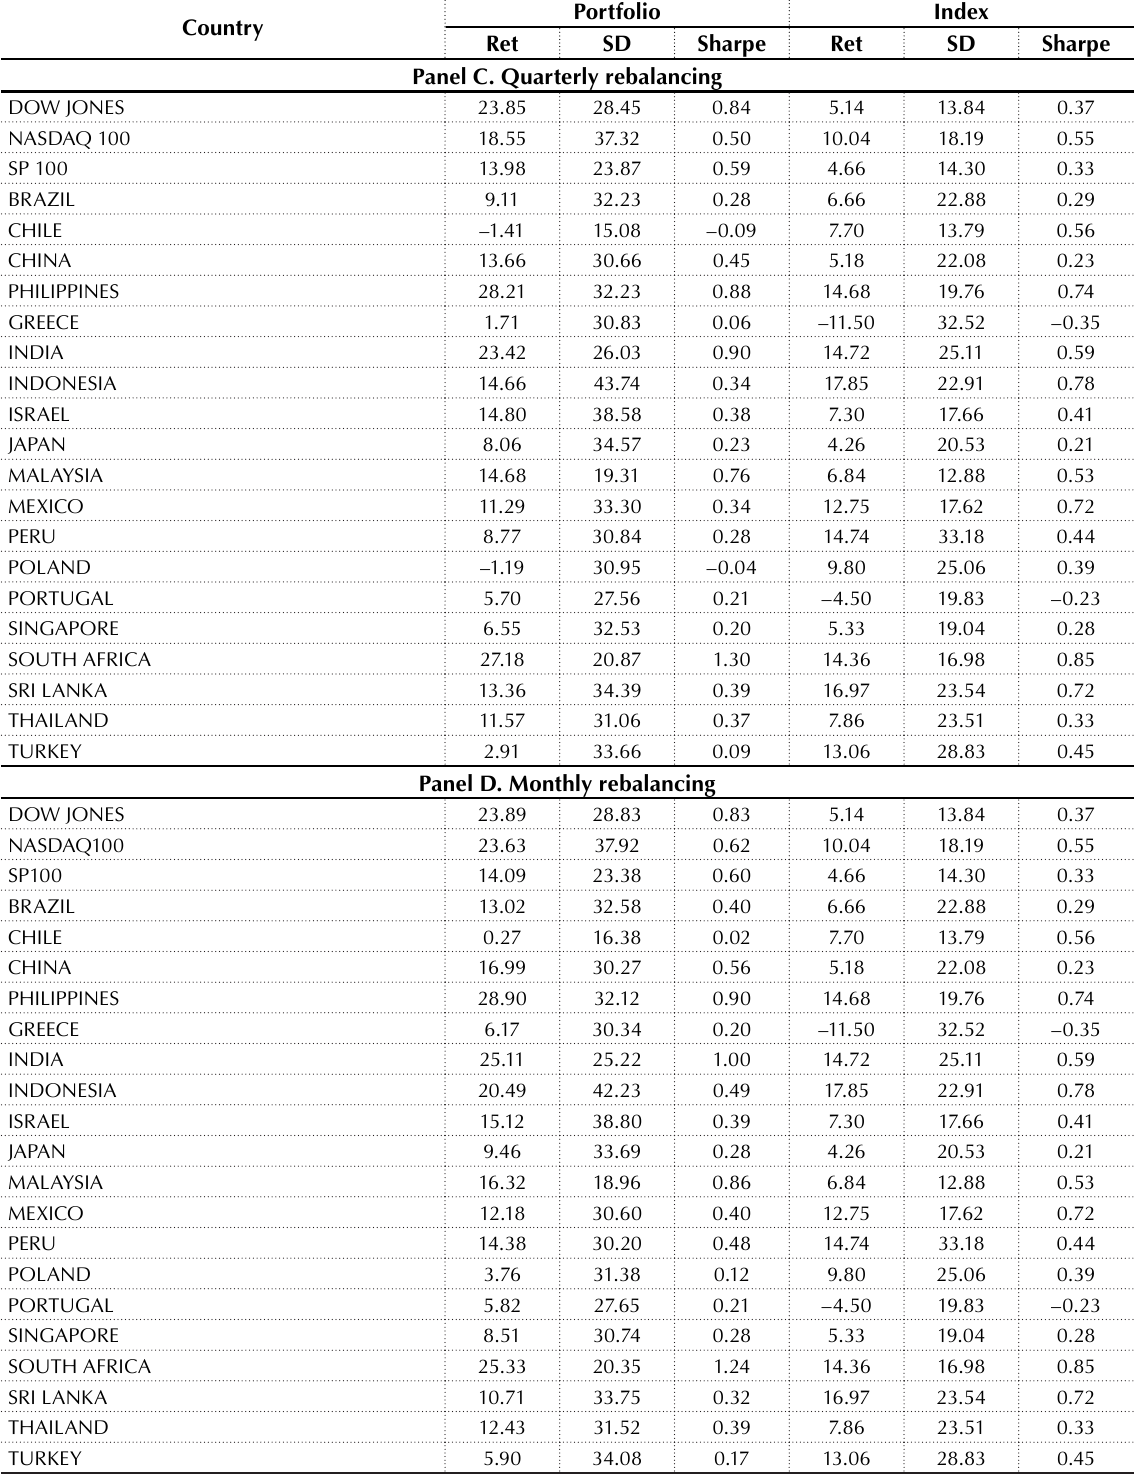
Table 2 (cont.). Performance of mean-variance optimized portfolios Portfolio Index Country Ret SD Sharpe Ret SD Sharpe Panel C. Quarterly